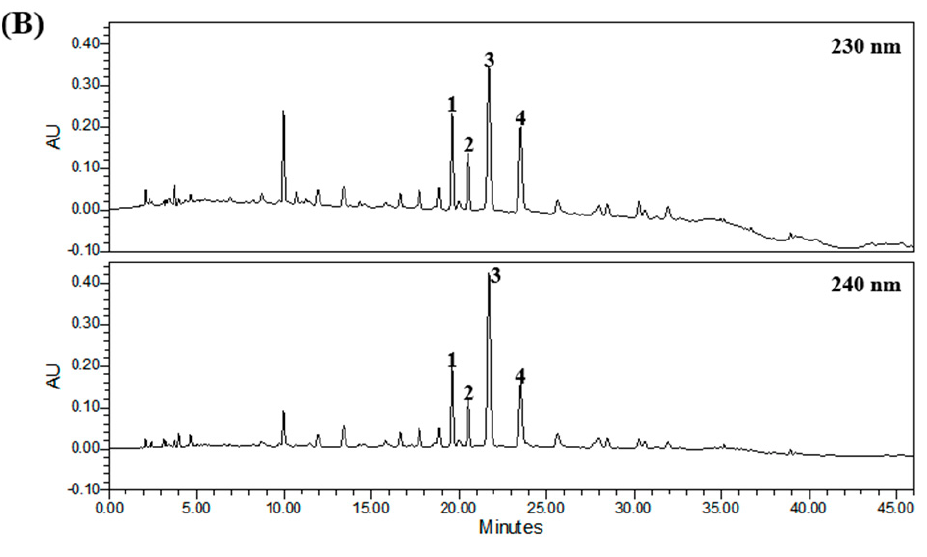
Figure 2. High-performance liquid chromatography (HPLC) chromatograms of standard mixtures ( A ) and a Haedoksamul-tang (HST) sample ( B ). (1), berberine; (2), palmatine; (3), geniposide; (4), paeoniflorin.